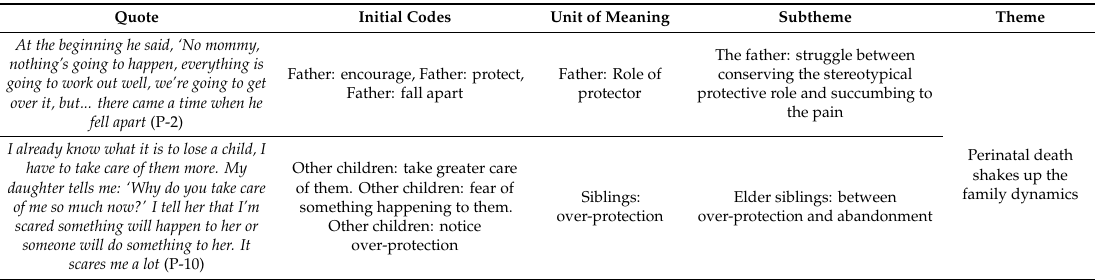
Table 3. Example of the codification process.